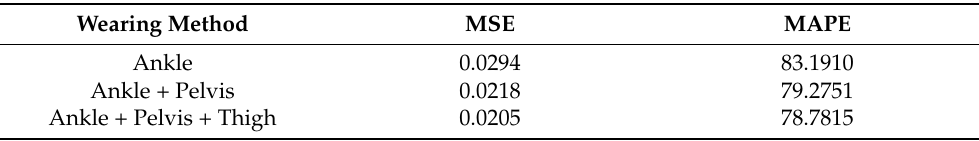
Table 4. Effect of the wearing method on